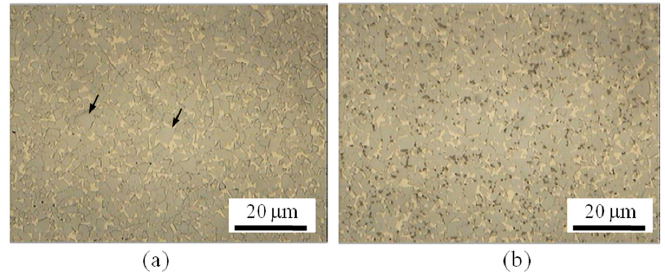
Figure 1. Optical micrographs of the microstructure: ( a ) 0 wt% of Cr 3 C 2 and ( b ) 1.5 wt% of Cr 3 C 2 .